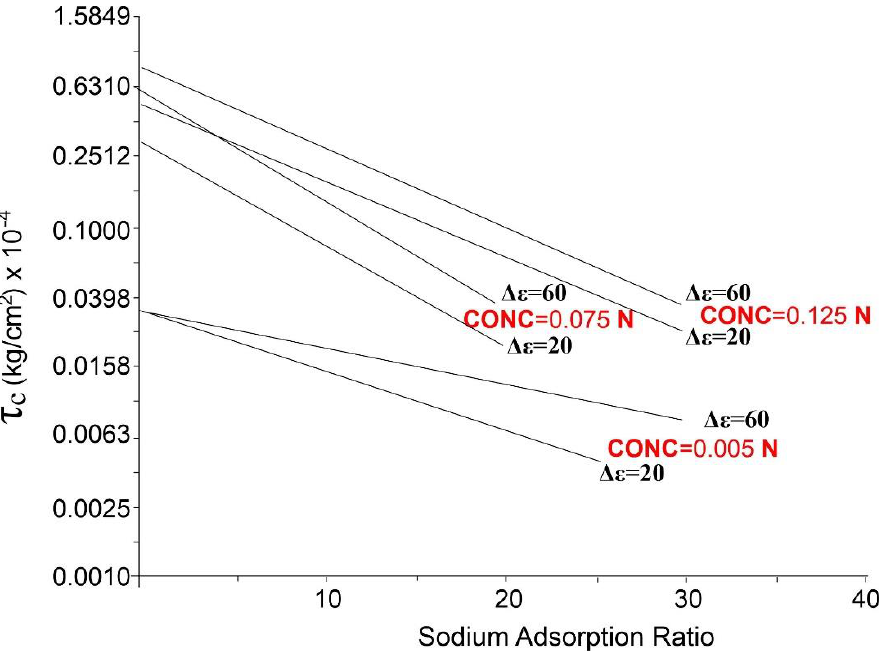
Figure 4. Critical Shear Stress τc versus SAR for Different Soil Salt Concentrations and different Dielectric Dispersion Values Δε (modified after [52]) .